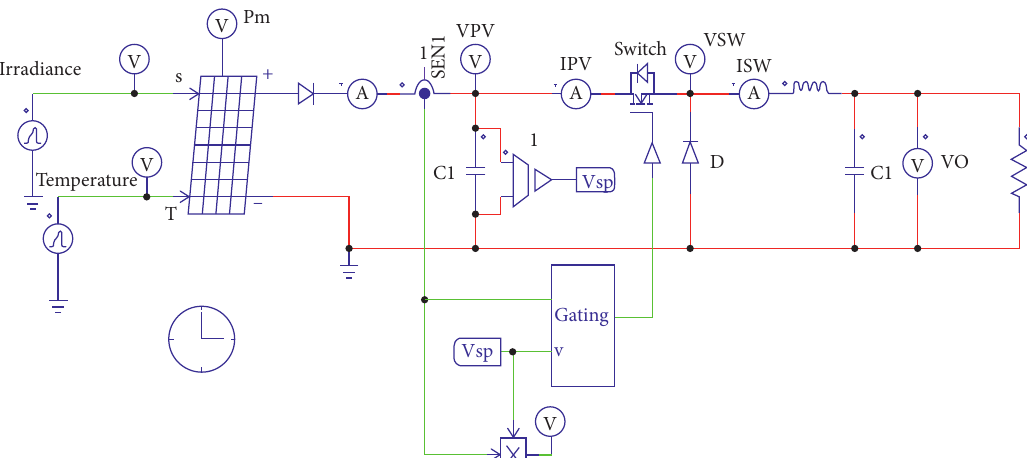
Figure 32: PV-based buck converter and MPPT conventional MPPT